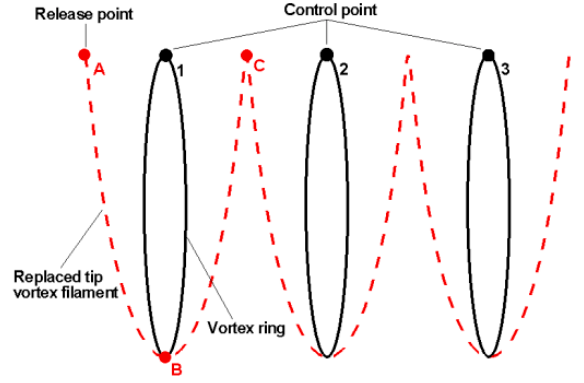
Figure 3. Schematic of the far wake.